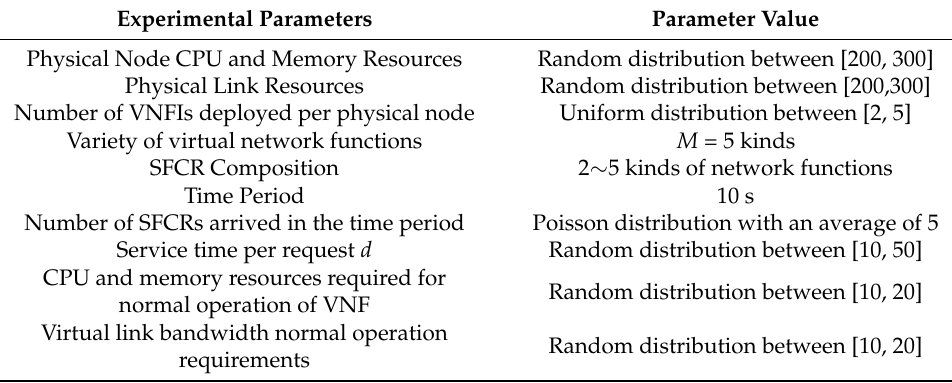
Table 3. Simulation experiment parameters configuration.